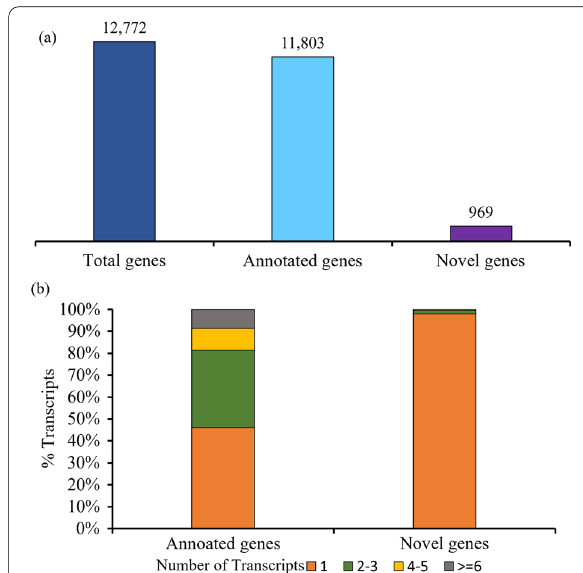
Fig. 1 PacBio transcriptome characterization: a quantification of total genes comprising of annotated genes and novel genes; b transcripts distribution across the annotated and novel genes. Annotated genes: annotated to the reference genome; Novel genes: not annotated to the reference